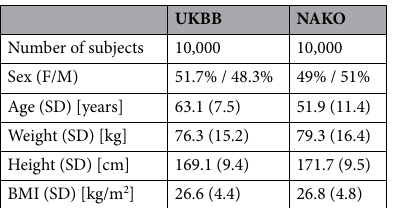
Table 1. Demographic characteristics of